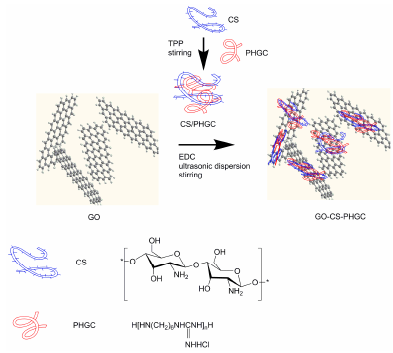
Figure 1. Synthetic route to GO-CS-PHGC.